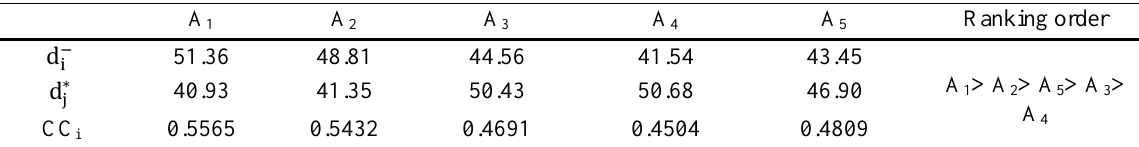
Table 10. Closeness coefficients (CCi) of the five alternatives.